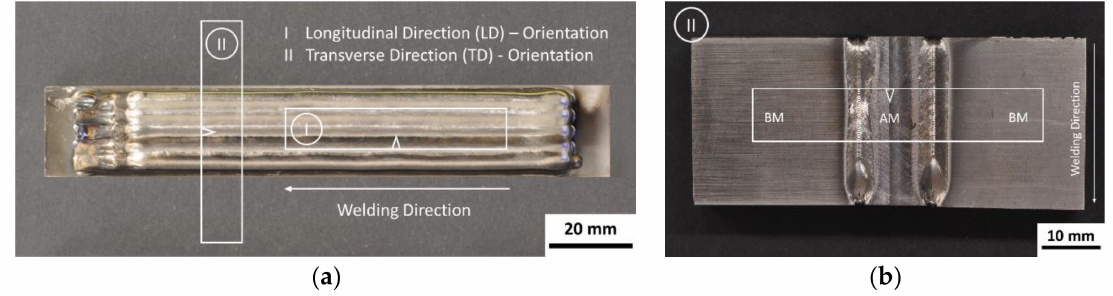
Figure 1. Charpy V-notch specimens: ( a ) orientation of the specimens in the AM blocks; ( b ) electron beam welded transverse Charpy V-notch